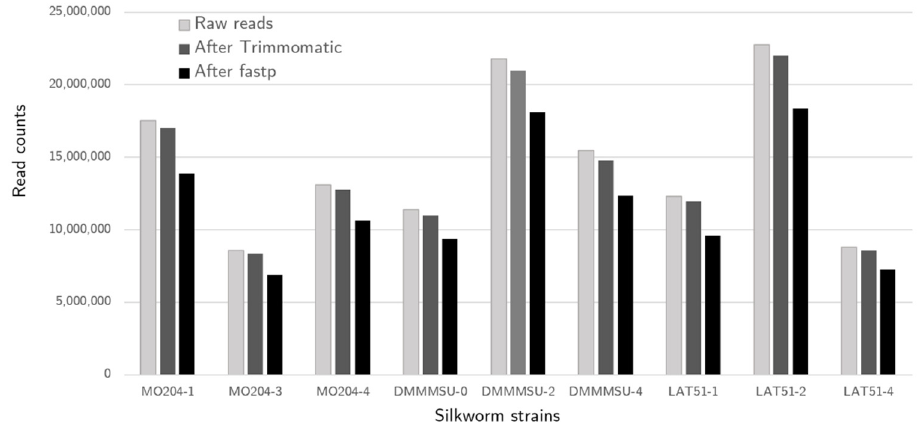
Figure 1. Bombyx mori raw read counts and proportion of reads after processing.